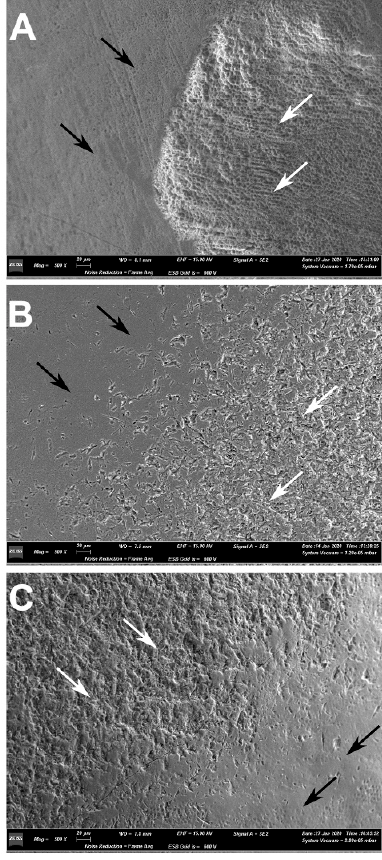
Figure 4. Scanning electron microscope (SEM) imaging of the teeth after application of different enamel conditioning treatments. Images were taken at 500× magnification under SE modality at high tension (15.0 kV), depicting the interface between the intact enamel and the conditioned surface. ( A ) acid etching (E group); ( B ) hydroabrasion (HA group); ( C ) acid etching and hydroabrasion (HA-E group); black arrows, intact enamel; white arrows, conditioned enamel.